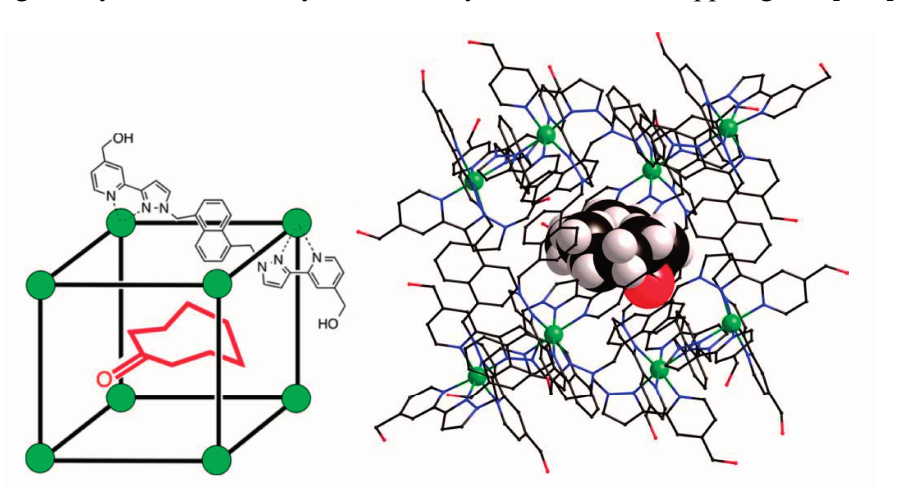
Figure 19. Host cage [Co 8 L 12 ](BF 4 ) 16 , complex with cycloundecanone, with a 55% occupancy of the cavity space, Co atoms in green [100]. With permission from Turega, S.; Cullen, W.; Whitehead, M.; Hunter, C.A.; Ward, M.D. Mapping the internal recognition surface of an octanuclear coordination cage using guest libraries J. Am. Chem. Soc. 2014 , 136